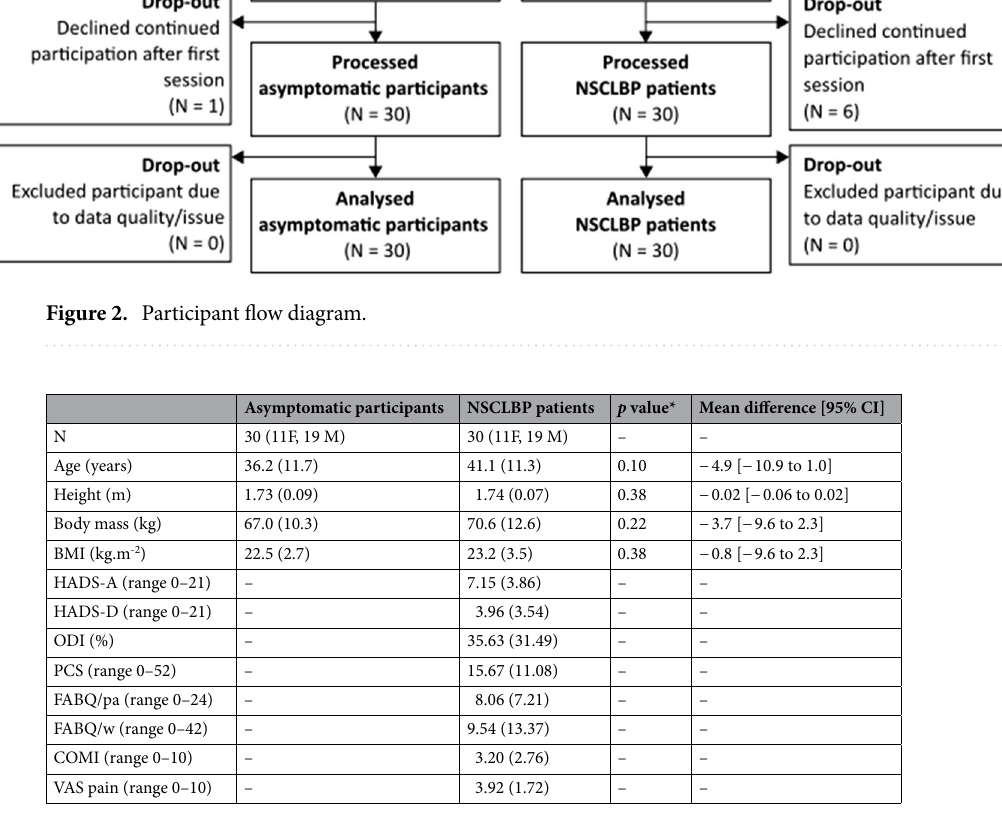
Table 3. Participants characteristics. *t test for independent samples (bold characters: p < 0.05). Data reported as mean (std). CI confidence interval, NSCLBP non-specific chronic low back pain, HADS hospital anxiety and depression scale, HADS-A HADS subscale related to anxiety, HADS-D HADS subscale related to depression, ODI oswestry disability index, PCS pain catastrophizing scale, FABQ fear avoidance belief questionnaire, FABQ/pa FAQB subscale related to physical activities. FABQ/w FABQ subscalerelated to work-related items. COMI core outcome measure index, VAS visual analog scale of pain (mean clinical pain over the past